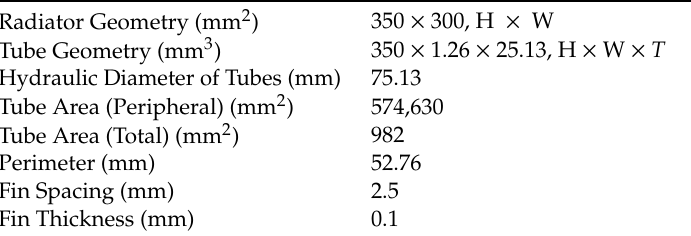
Table 3. Radiator